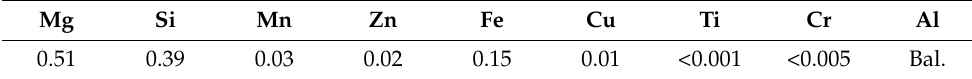
Table 1. Chemical composition of the 6063 aluminium alloy